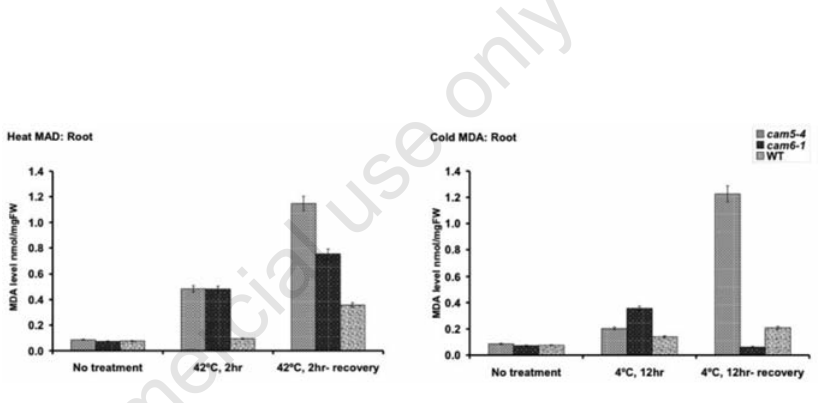
Figure 3. Oxidative damage in cam mutants of A. thaliana after exposure to low temper- ature at 4°C. Malonaldehyde (MDA) level was determined in root and shoot tissues by the thiobarbiturate reactive substances (TBARS) assay describe in materials and meth- ods. Two sets of seedlings were treated at 4ºC for 12 hr. One set was used immediately for measurement of MDA level while the other set was allowed to recover for 2 days under continuous light at 25oC before determination of MDA level. Error bars represent the standard deviation over three replicate plates with 50 seedlings on each plate.